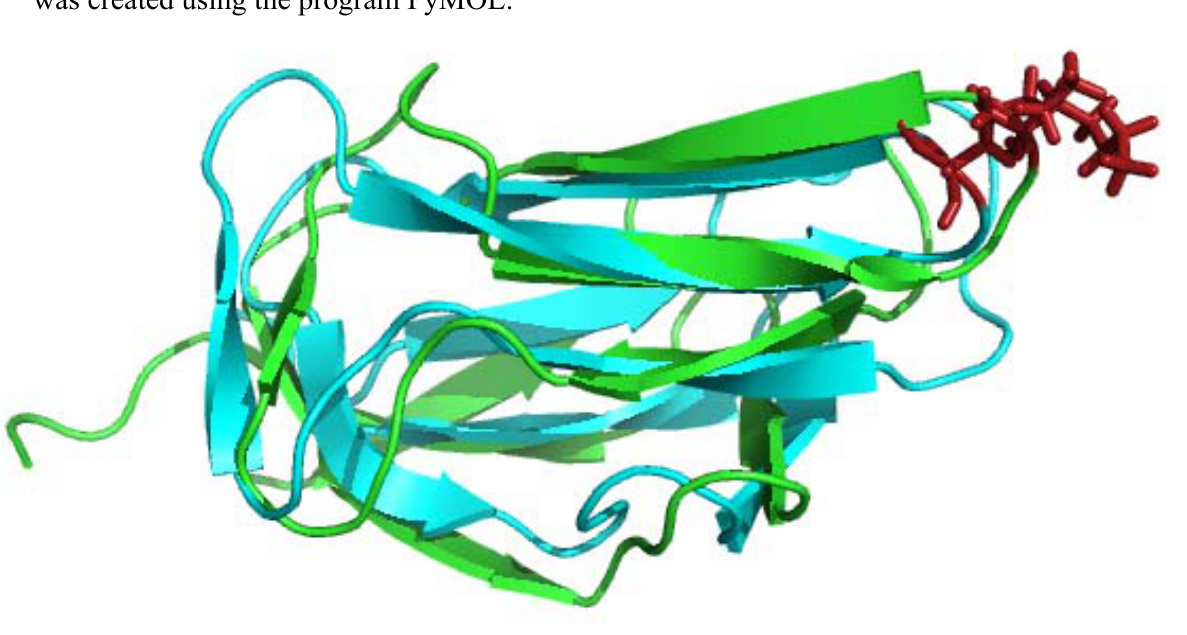
complex (Green; PDB Id:1QJO) [81] and lipoyl domain OGDHc complex from E. coli (Cyan; PDB Id: 1PMR) [14]. Lipoyl lysine residue is highlighted in stick form. The image was created using the program